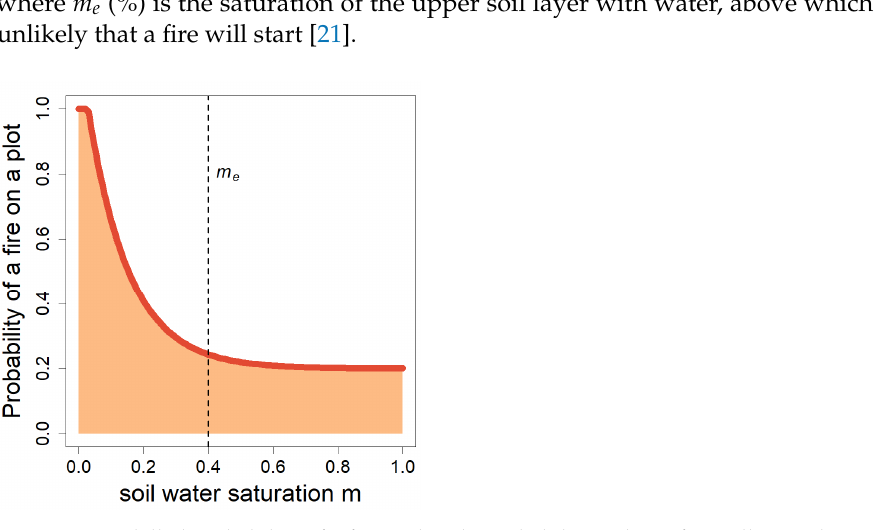
Figure 6. Modelled probability of a fire outbreak. Probability B that a fire will spread on a forest plot in the fire area, depending on the water saturation m in the topsoil layer (here m e = 0.4=40%).